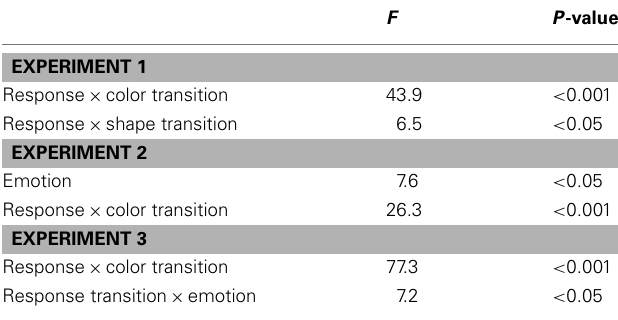
Table 2 | Significant main and interaction effects on R2 response